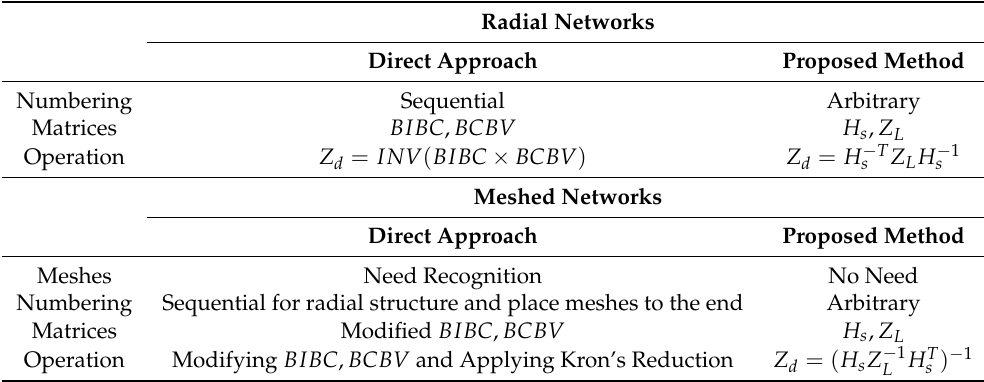
Table 1. Comparison with Direct Approach.